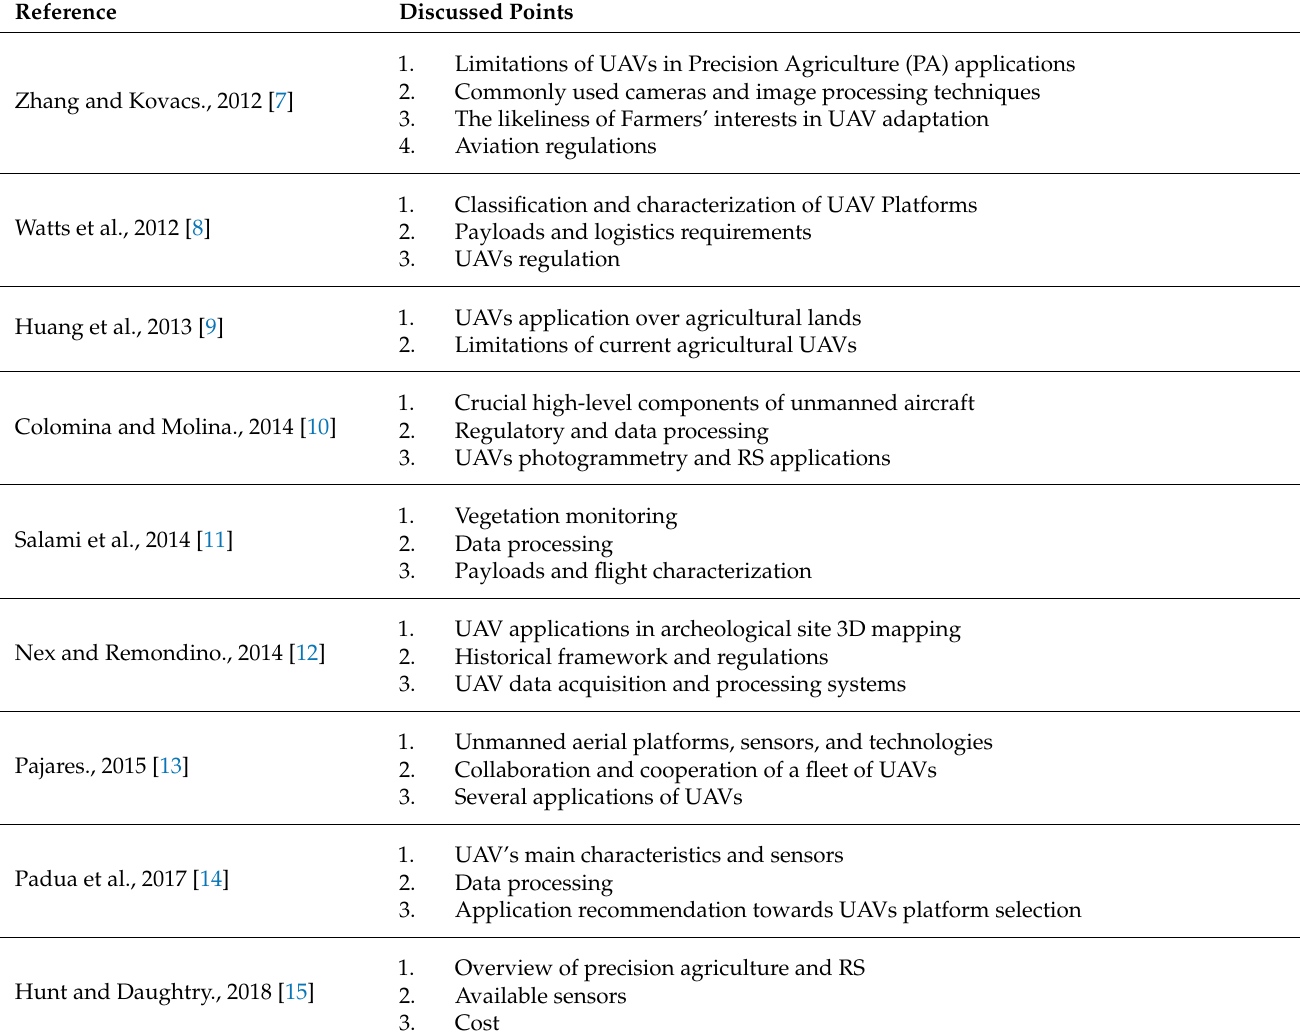
Table 1. Review studies on UAVs and their main